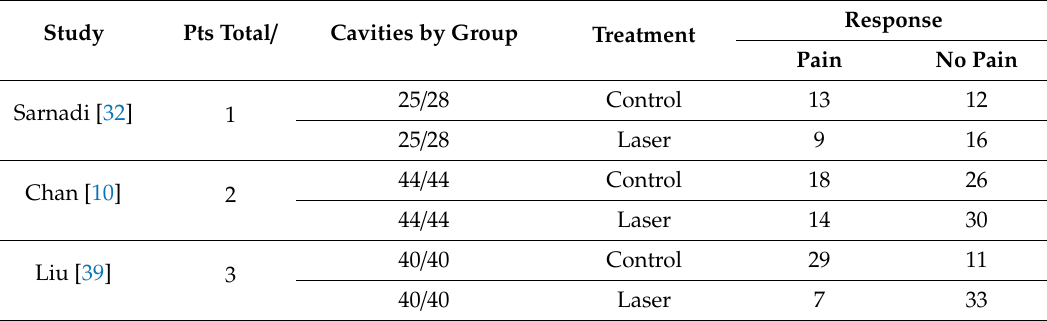
Table 3. Statistical analysis was performed on a combination of three split-mouth studies in which it was possible to classify the responses as pain experience or no pain. Data extracts allowed comparative patient numbers to be computed and